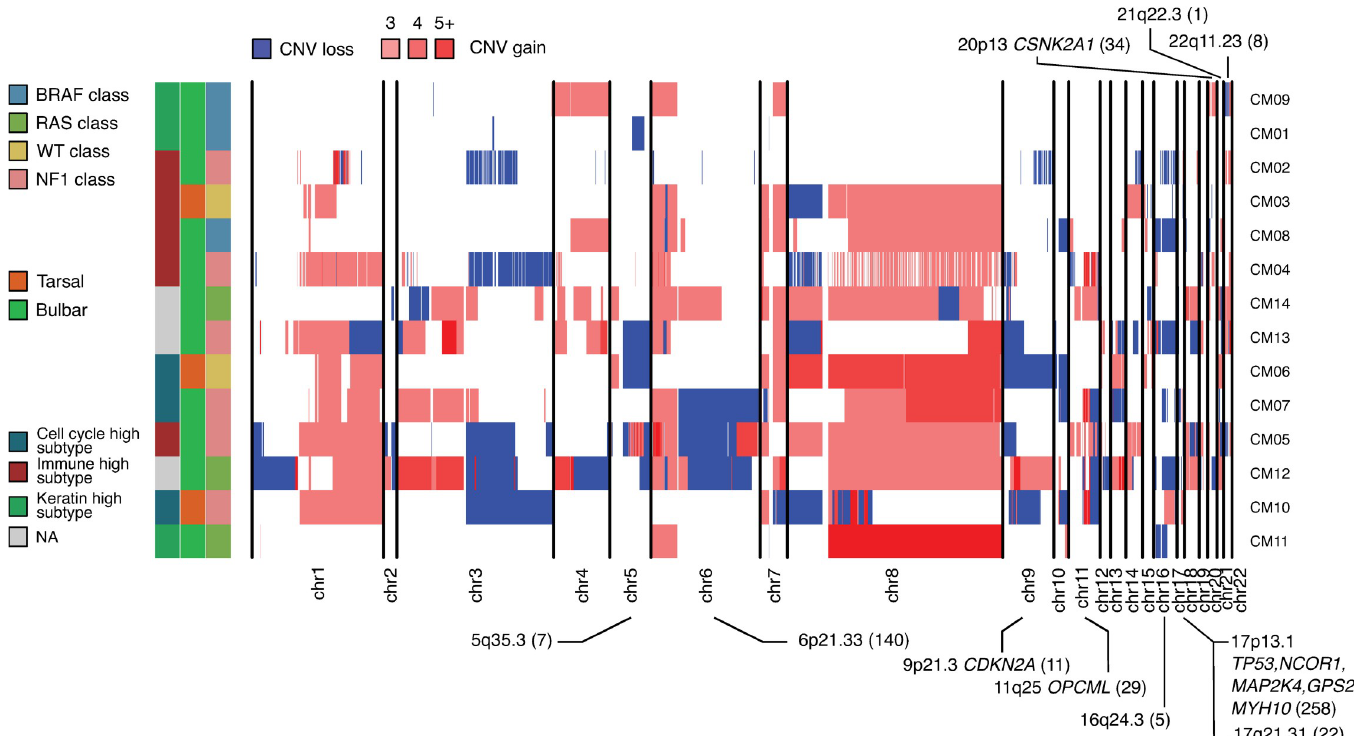
Fig 5. Landscape of CNVs in CJM. Sub-chromosomal level CNVs are shown, in relationship to specific characteristics of each